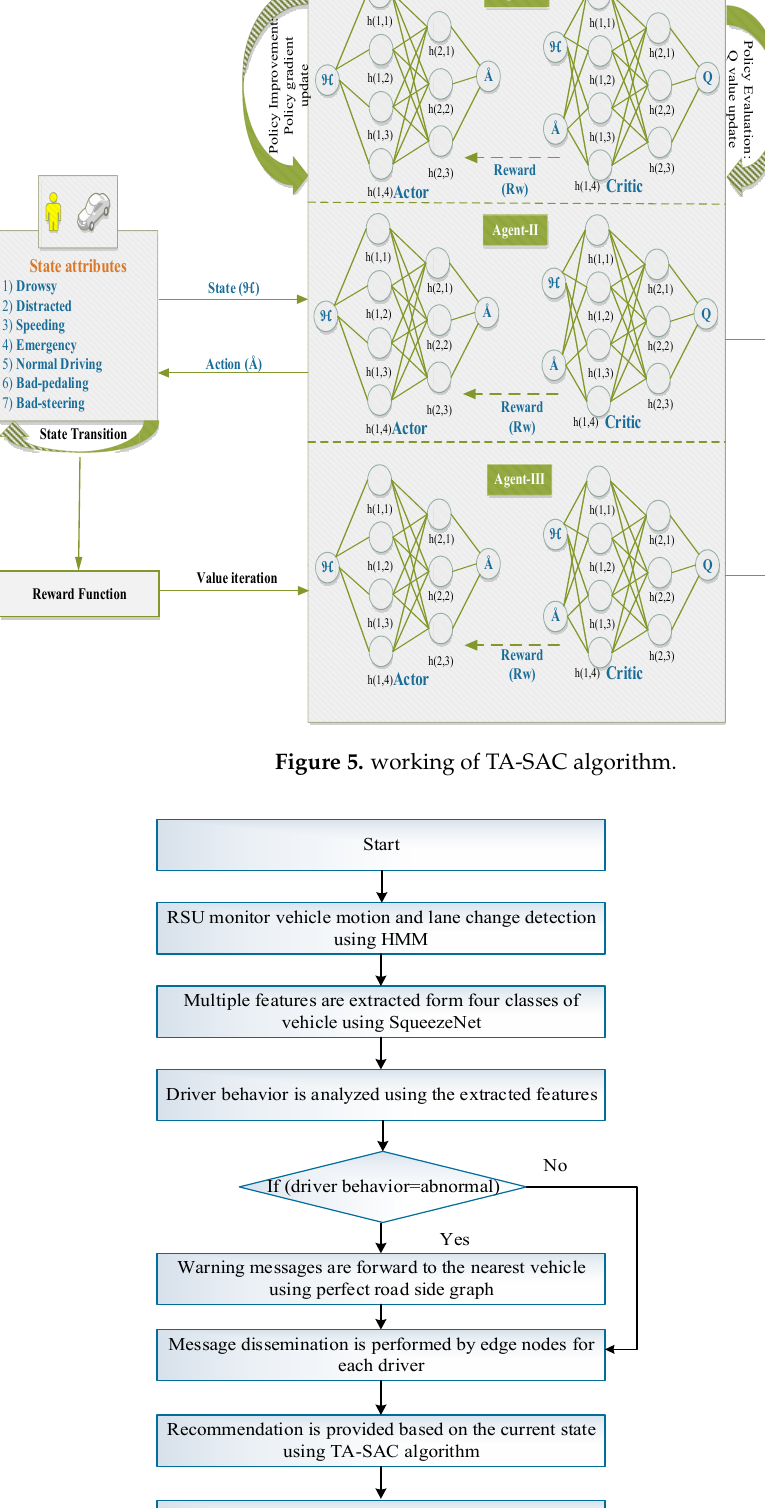
Figure 6. Overall Flowchart.